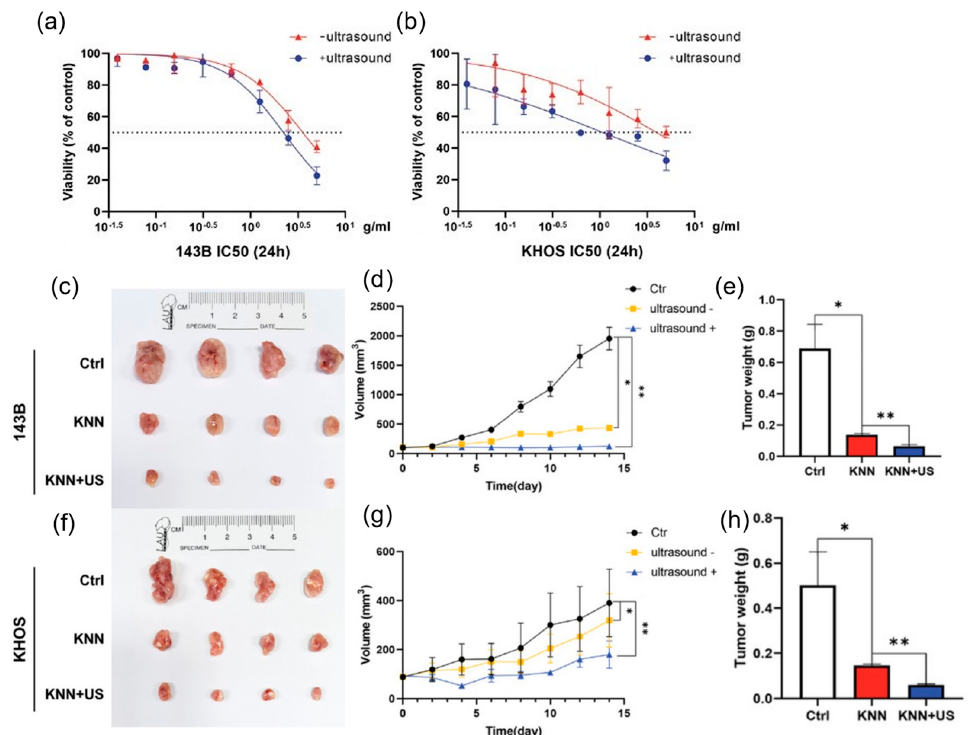
Figure 7. ( a , b ) 143B and KHOS cell viability in the presence of KNN with and without ultrasonication. ( c ) Photo images of the tumors from 143B cell xenografts under different treatments. ( d , e ) 143 B cell xenograft tumor growth (n = 4, * p < 0.05, ** p < 0.01). ( f ) Images of tumors created using KHOS cells from the xenografts of different treatments. ( g , h ) KHOS cell xenograft tumor growth. Reproduced with permission (n=4, *p < 0.05, **p < 0.01) [53] . Copyright 2022, Wiley − VCH.